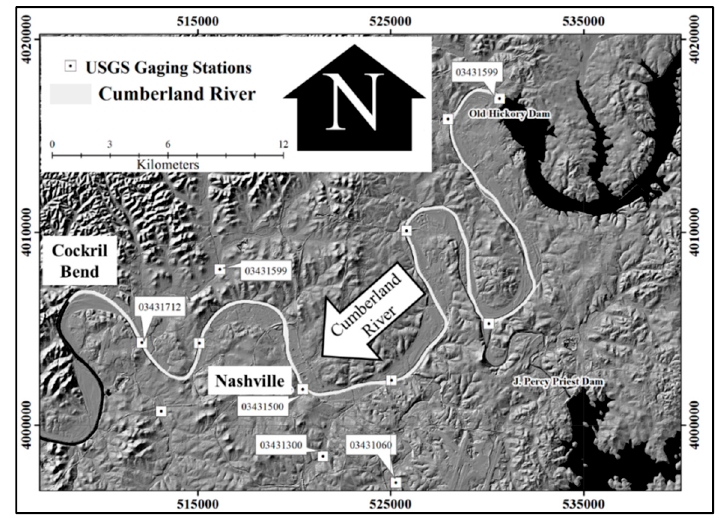
Figure 2. Study area of the Cumberland River (shown in gray) along with nearby water bodies and U.S. Geological Survey (USGS) stream gages (shown in white boxes).